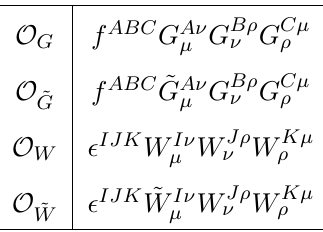
Table 6. 2HDM: X 3 [4] class of